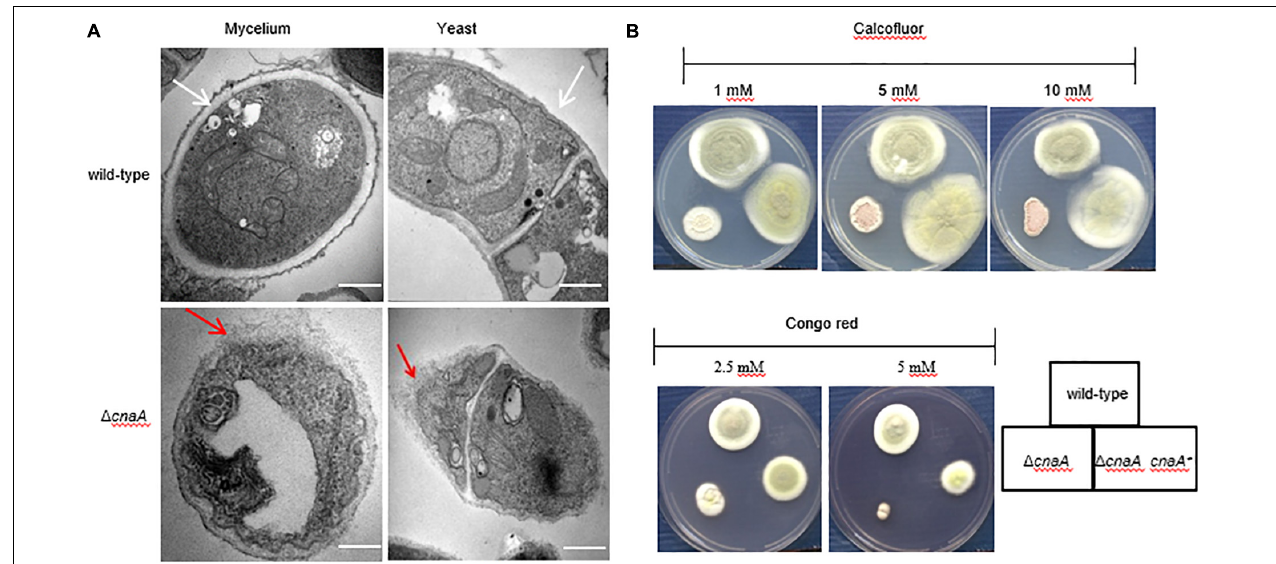
FIGURE 4 | The cnaA gene is required for correct cell wall biosynthesis. (A) The morphology of the strains was observed by TEM after 10 days of growth in ANM medium at 25 ◦ C and 37 ◦ C. The cell wall of the wild-type strain was smooth and intact in the hyphal and yeast forms in vitro , and the organelles were clearly visible (white arrow). In contrast, the (cid:49) cnaA mutant showed cell wall deformation with less distinct layering, and the organelles of the mutant appeared disordered (red arrow). Scale bars, 0.2 µ m. (B) Strains were grown on ANM medium at 25 ◦ C after the addition of various concentrations of calcofluor white or Congo red. Compared with the wild-type, the (cid:49) cnaA mutant showed greater sensitivity to Congo red at concentrations of 5 mM, but there was no difference in calcofluor white staining.